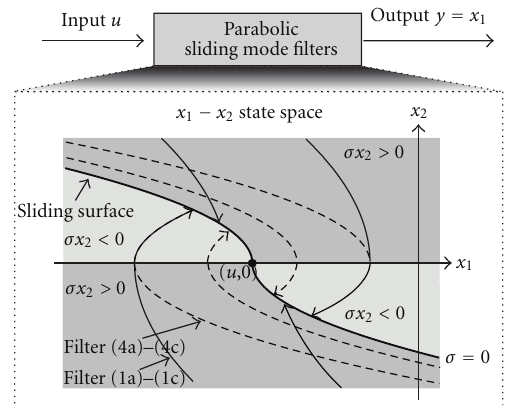
Figure 2: The parabolic-shaped sliding surface (thick solid curve, σ = 0) and trajectories of the state ( x (1c) (thin solid curve) and filter (4a)–(4c) (thin dotted